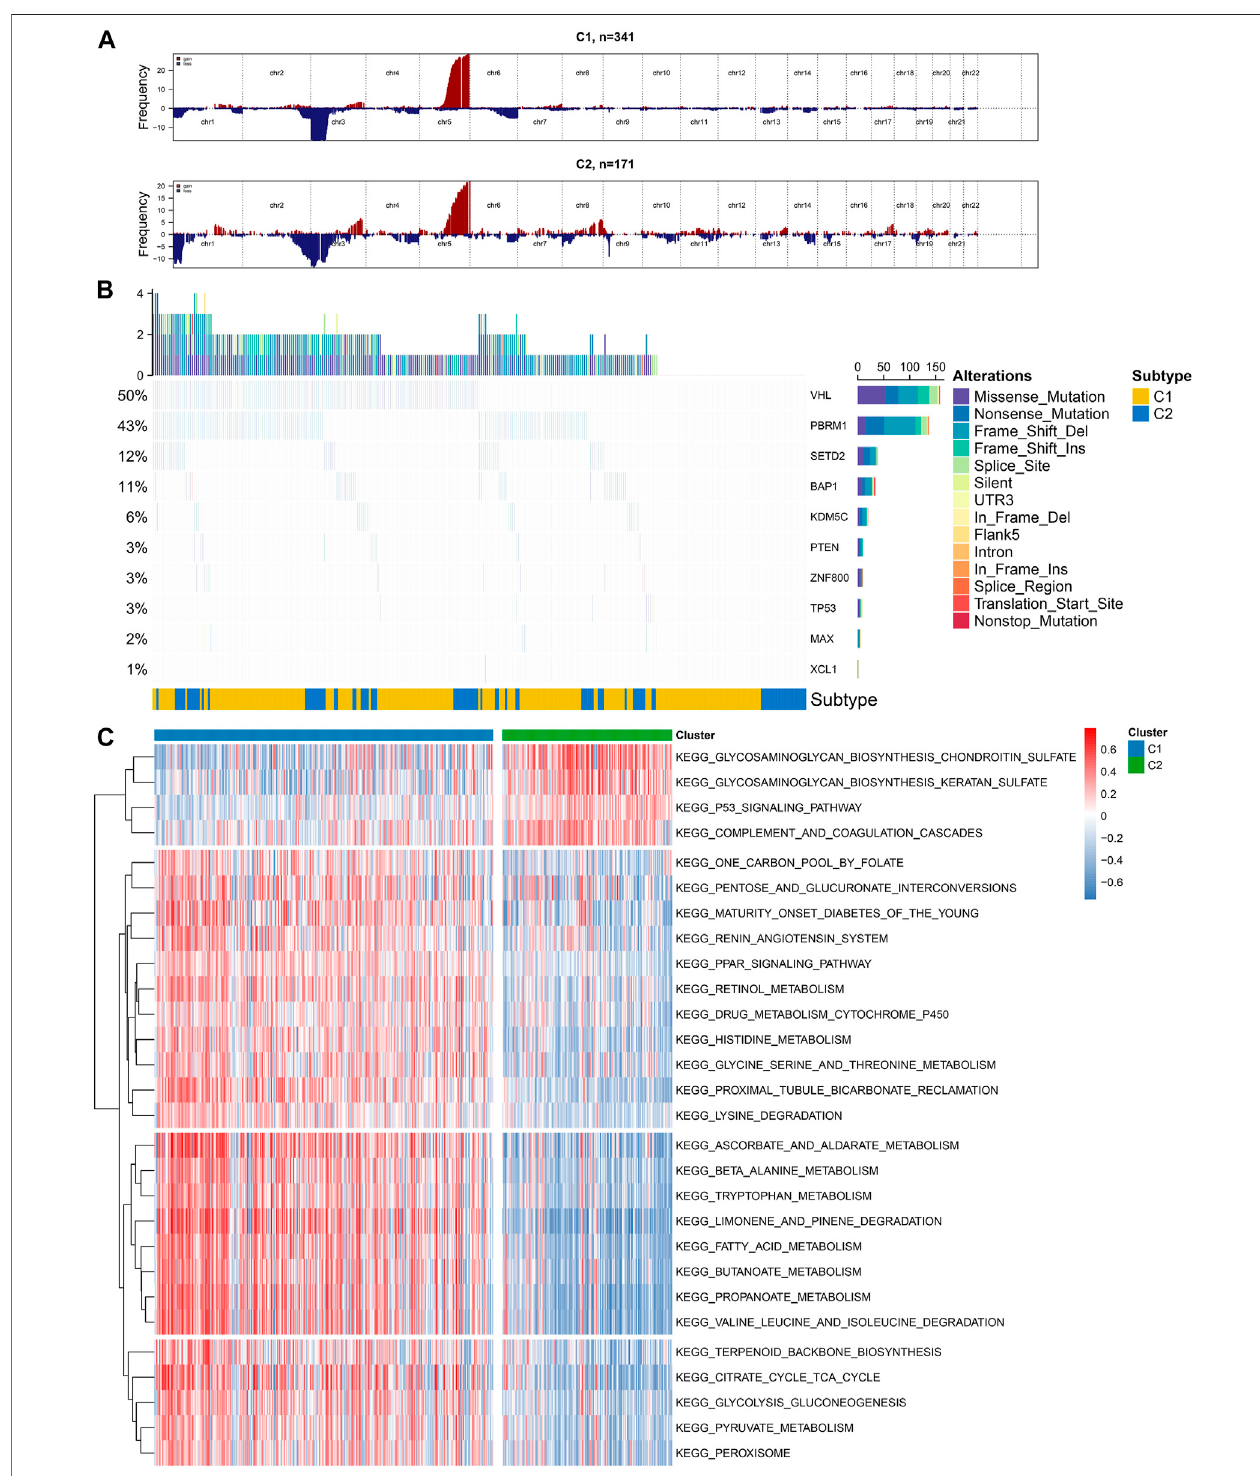
FIGURE 2 | Illustration of copy number and somatic variations and subtype-speci fi c signaling pathways in two hypoxia-related molecular subtypes (A) The landscapeofcopynumber alterations inC1and C2subtypes (B) OncoplotvisualizingthesomaticlandscapeofccRCC samplesinthetwosubtypes. Thetoptengenes are ranked on the grounds of the mutation frequency. Different mutation types are annotated by different colors on the right (C) Heatmap showing subtype-speci fi c signaling pathways.